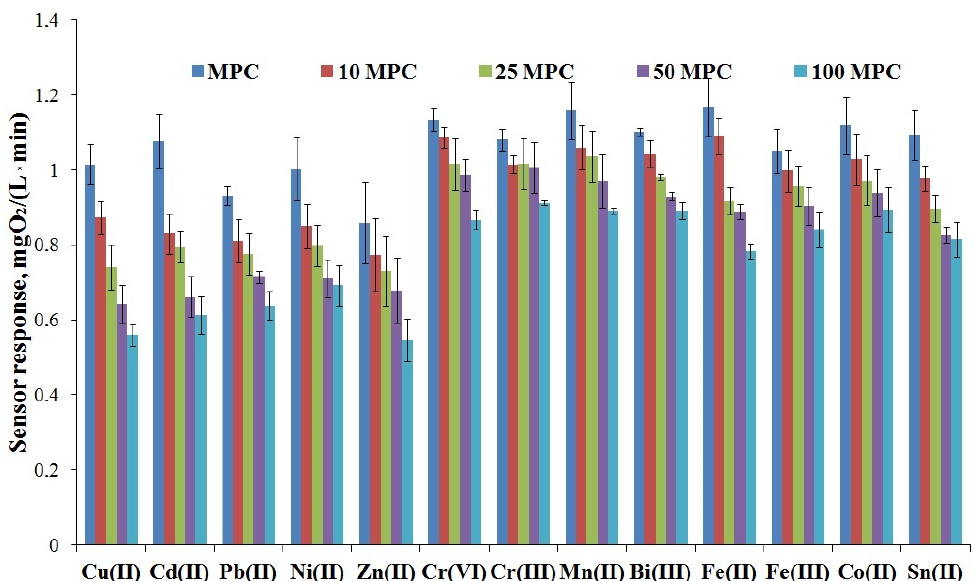
Figure 8. Effect of heavy metal ions on the respiration activity of yeast cells immobilized in ica composites ( ± standard deviation, n = organosilica composites (± standard deviation, n = 10).